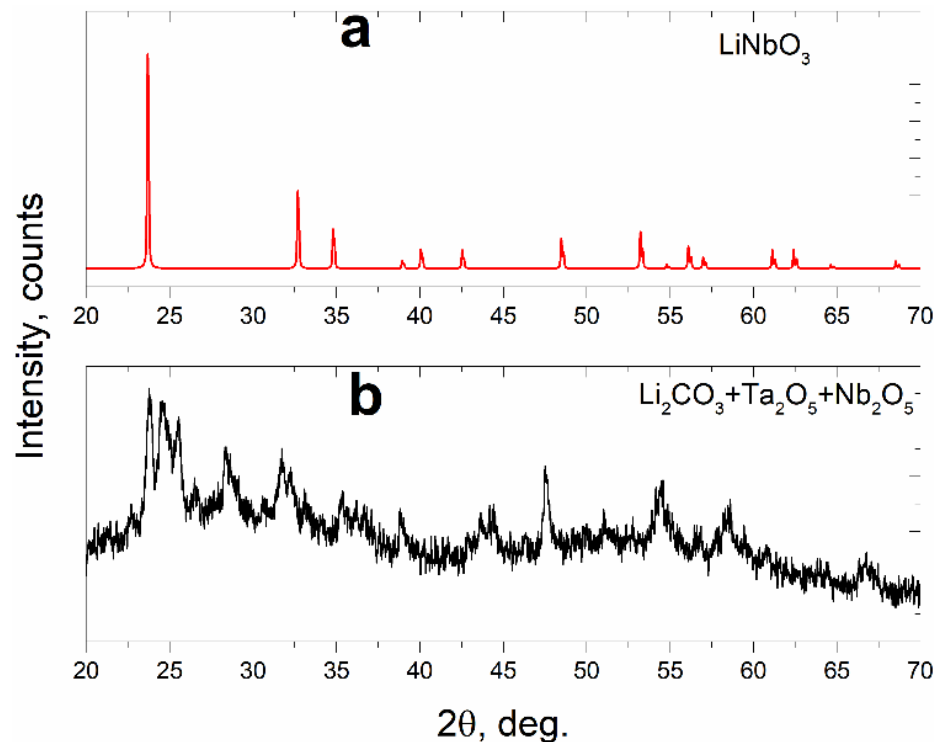
Figure 1. Reference diffraction patterns of lithium niobate ( a ) and diffraction patterns of the precursor obtained after milling a mixture of powders of lithium carbonate, niobium pentoxide, and tantalum pentoxide ( b ).